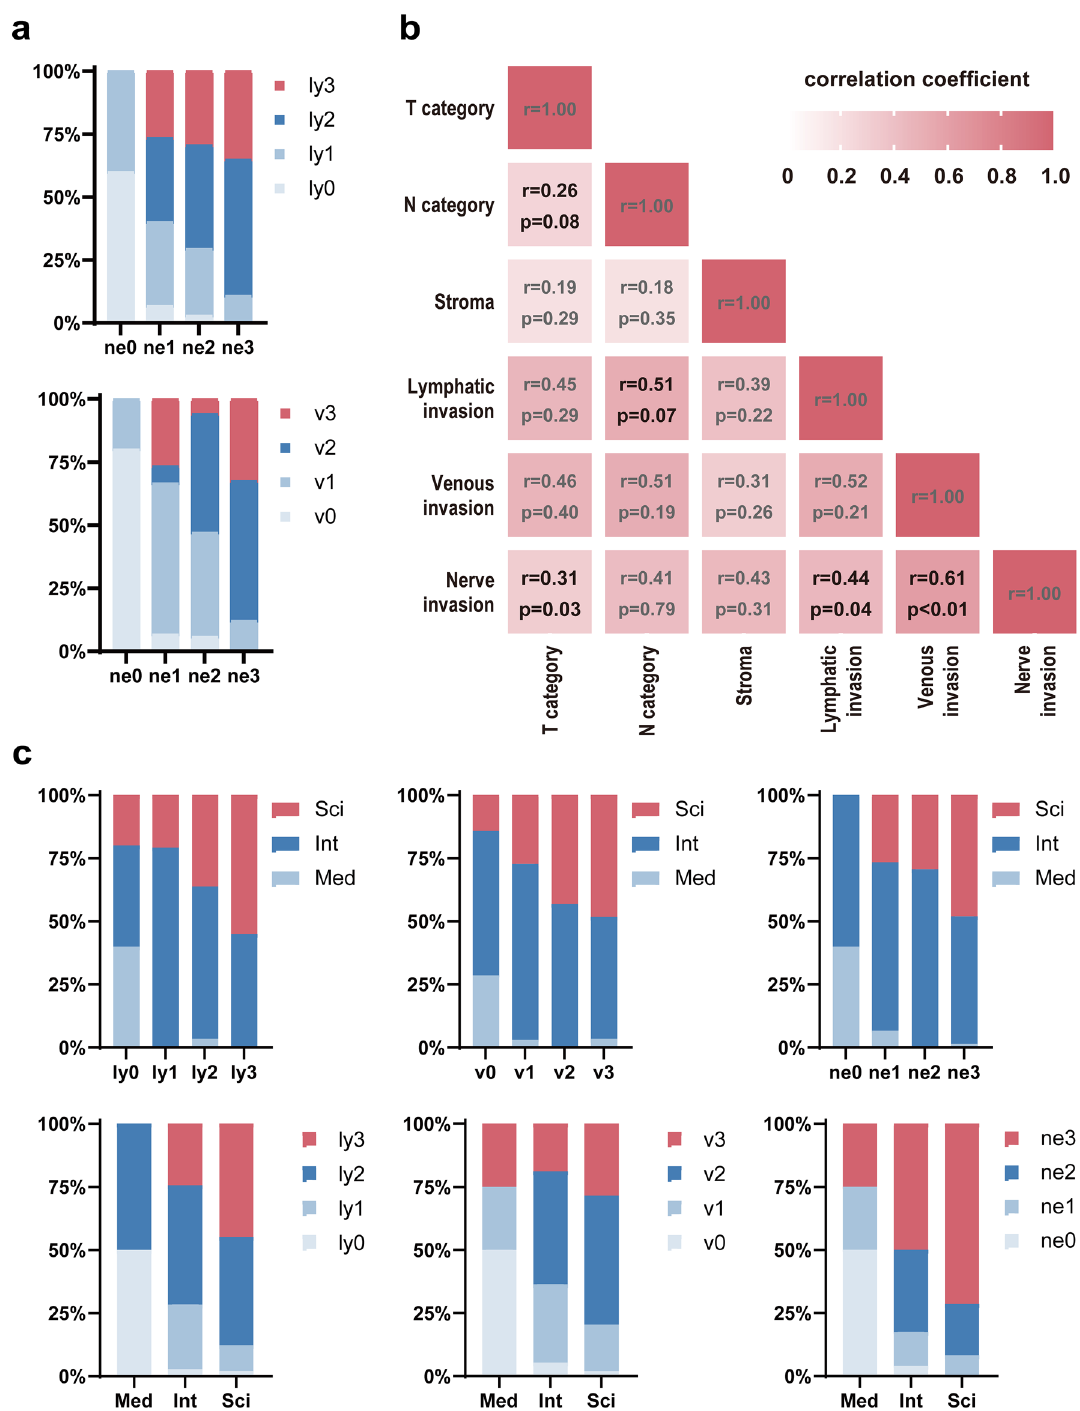
Figure 3. The relationship between nerve invasion and other pathological findings. ( a ) The lymphatic and venous invasions occurred alongside nerve invasion even in the early-stage PDAC. ( b ) The polychoric correlations among the pathological findings. ( c ) The correlation between the density of the stromal component and lymphatic invasion, nerve invasion, and venous invasion. Int intermediate type, ly lymphatic invasion, med medullary type, ne nerve invasion, sci scirrhous type, v venous